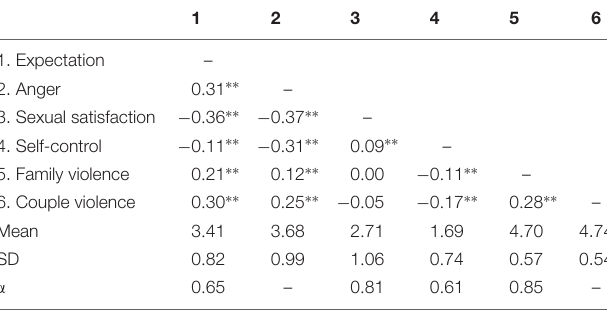
TABLE 2 | Scale inter-correlations and descriptive